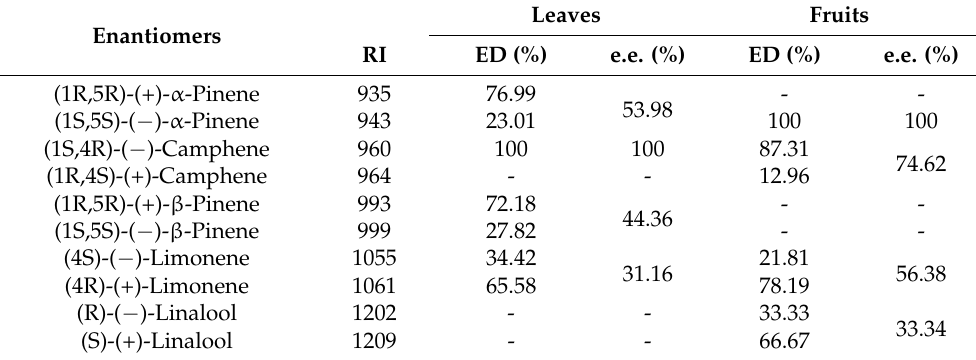
Table 2. Chiral compounds present in the essential oil from the leaves of fruits of Siparuna muricata .